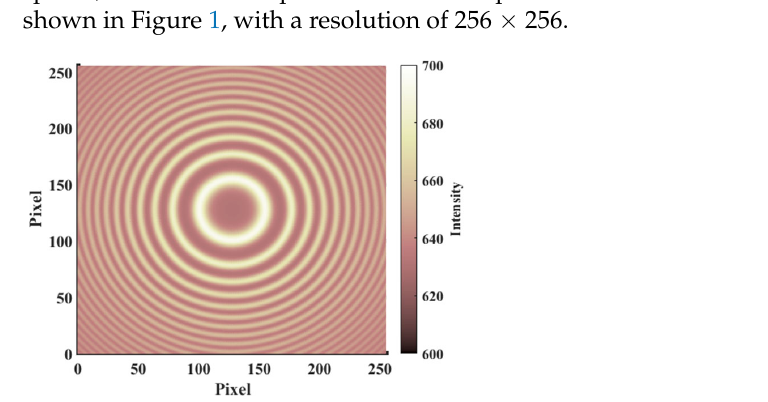
Figure 1. Simulated interferogram with V = 50 m/s, T = 600 K.